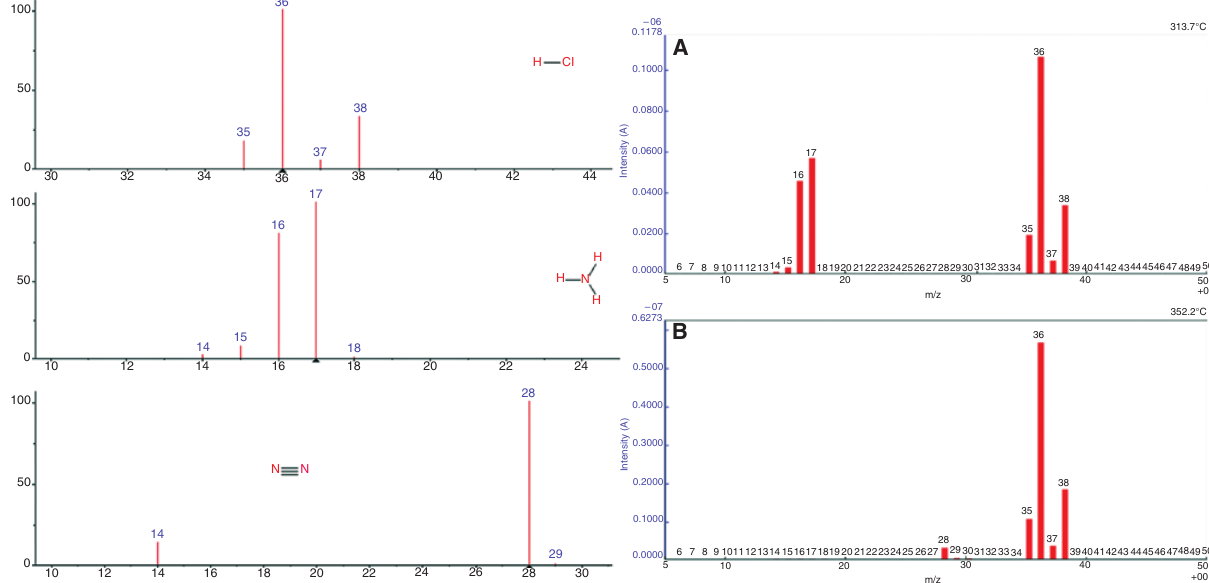
) RuCl powder in different heating temperatures. 4 2 6